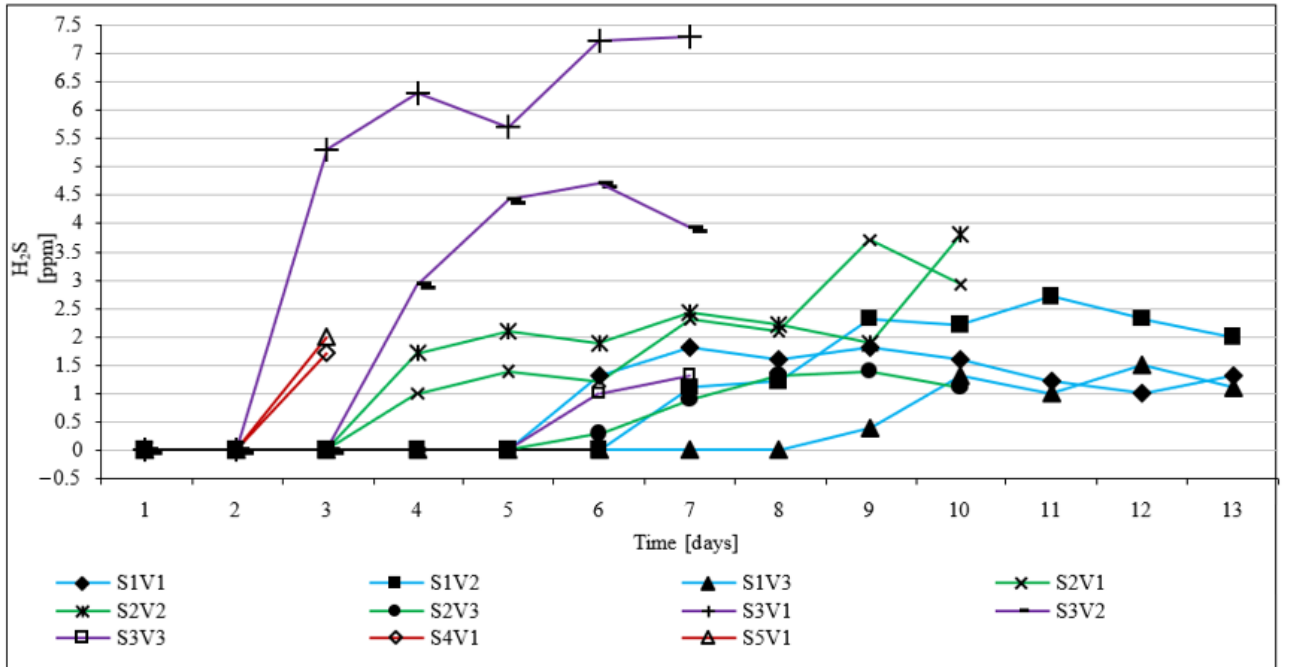
Figure 5. Changes in H 2 S in the biogas across variants.